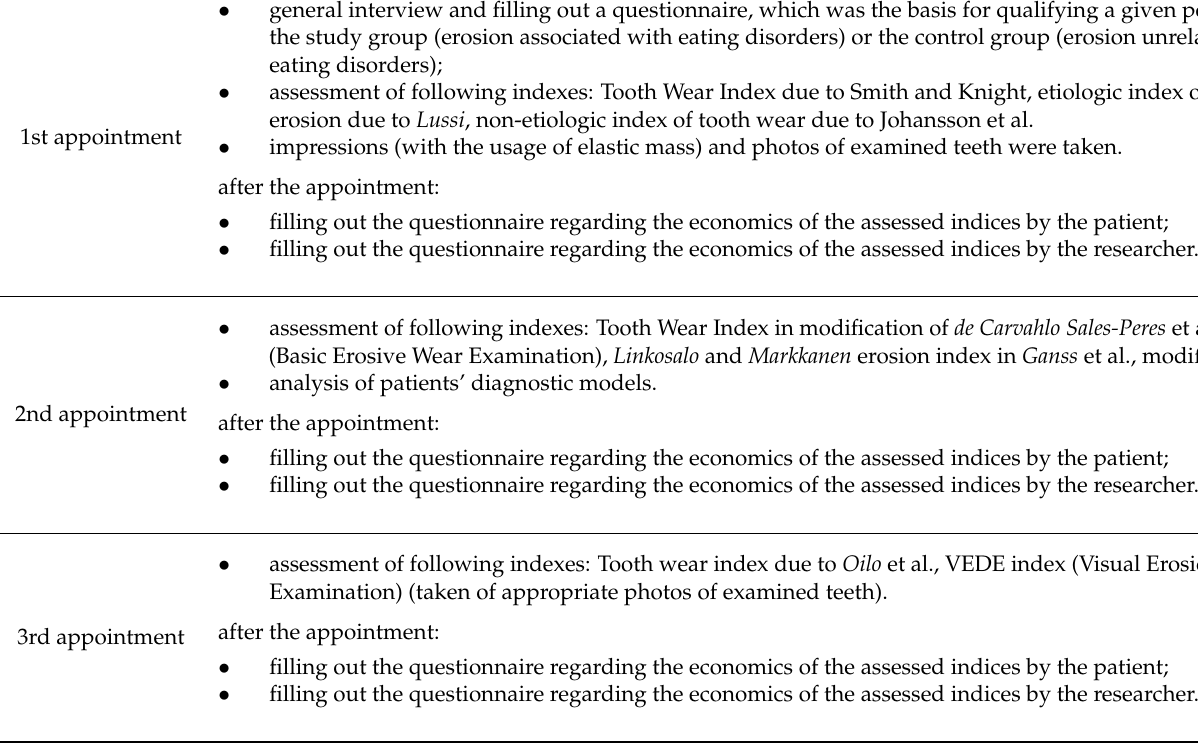
Table 2. Linkosalo and Markkanen’s index modified by Ganss et al. [20].